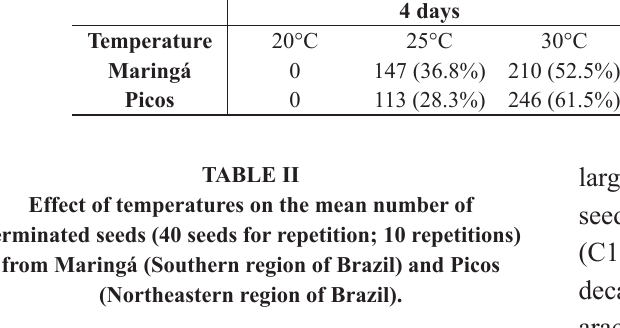
771 GENETIC AND CHEMICAL DIVERSITY IN MANDACARU